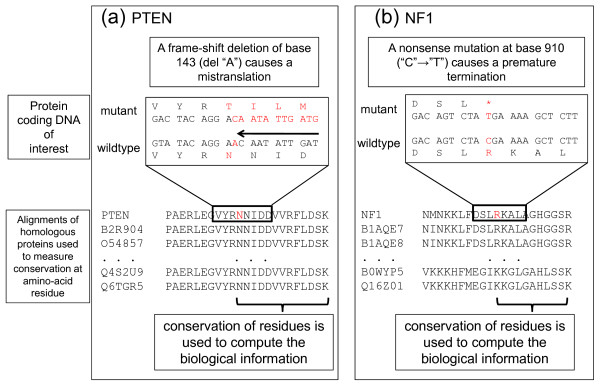
Computation of the information loss score for variations in the protein-coding DNA. (a) Deletion of DNA base "A" at site 143 of the human protein PTEN causes a reading frame-shift (depicted by an arrow to the left on DNA sequence) that results in the mistranslation of all residues after the mutation. An alignment of homologous proteins is used to measure the biological information content of the reference sequence (PTEN in the figure) and to measure the loss of information due to this mistranslation. (b) A NM at the DNA site 910 on the human protein NF1 causes a premature stop codon at the residue 304 (denoted by *). The mutant protein is missing residues after the premature stop codon.